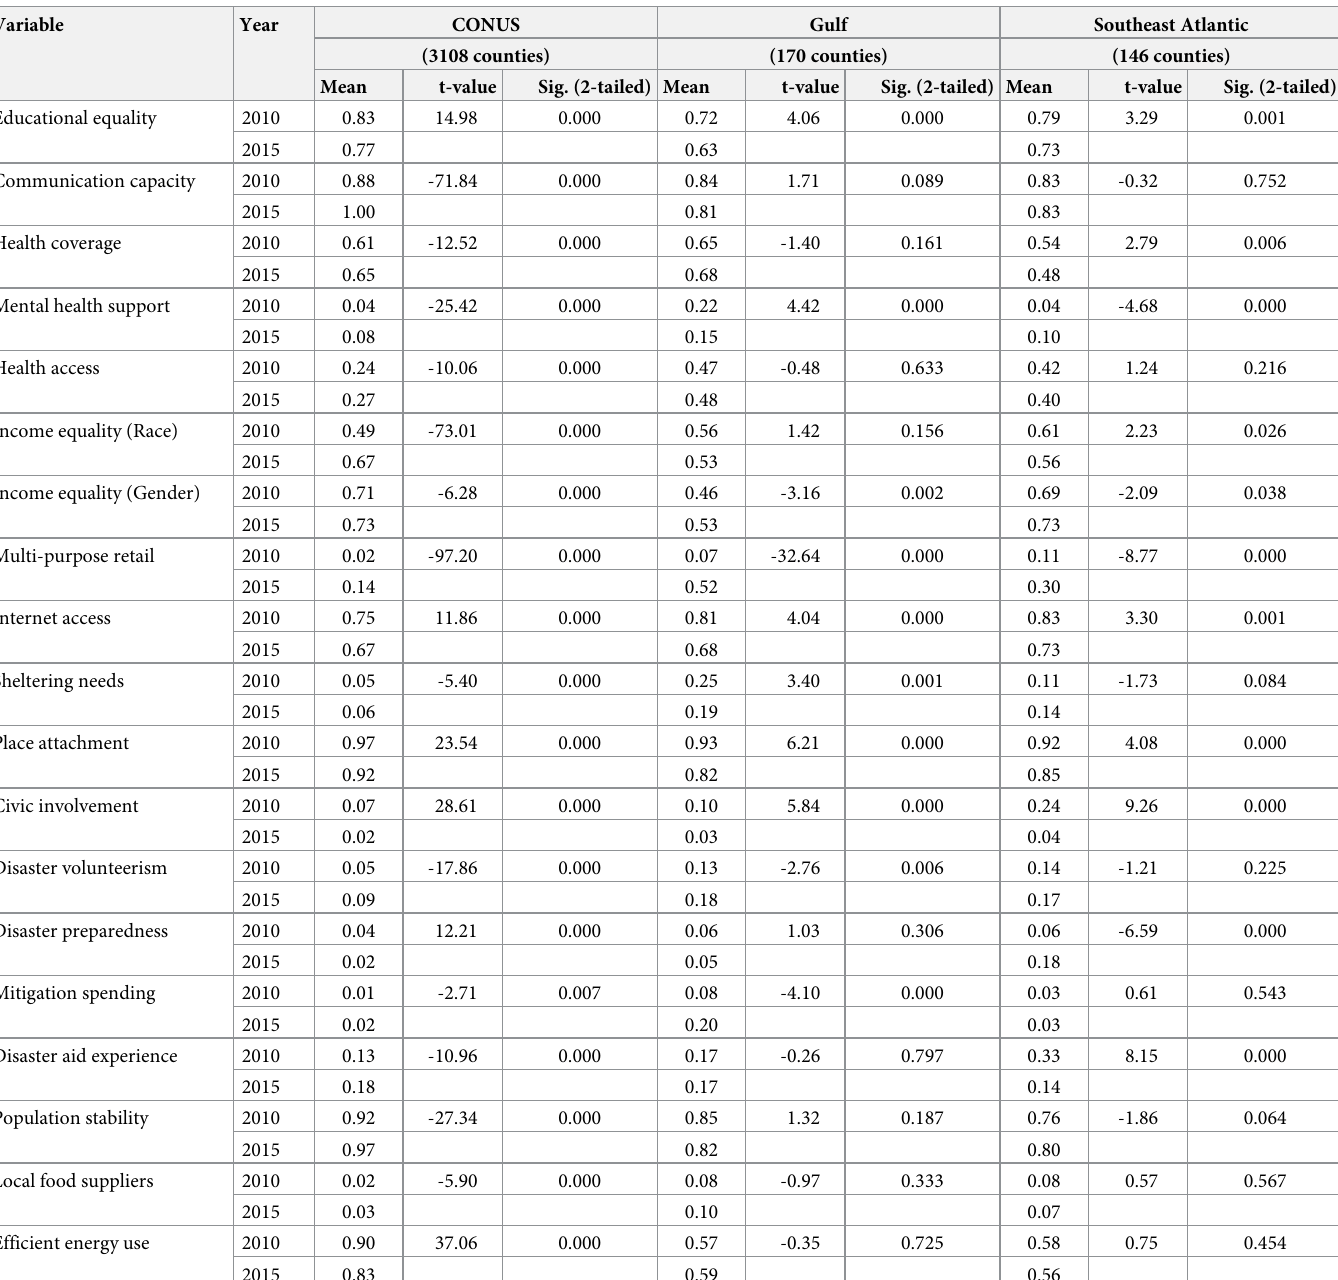
Table 4. Difference of means for BRIC input variables 2010 and 2015 �